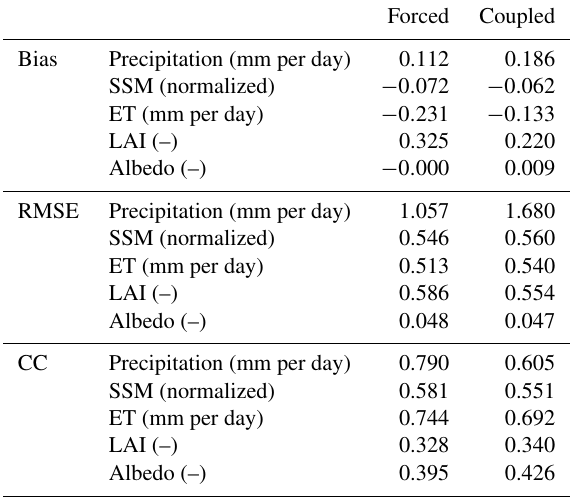
Table 3. Land averages of the evaluation criteria (bias, RMSE, and CC) for the selected variables and reference data sets. The same bias on the average over land for all variables was observed between forced and coupled simulations. Positive systematic bias was ob- served for LAI, and a large uncertainty (i.e., RMSE) was observed for SSM and ET. ET shows the best correlation coefficient. Overall, the coupled simulation tends to behave more realistically, despite the overestimation of